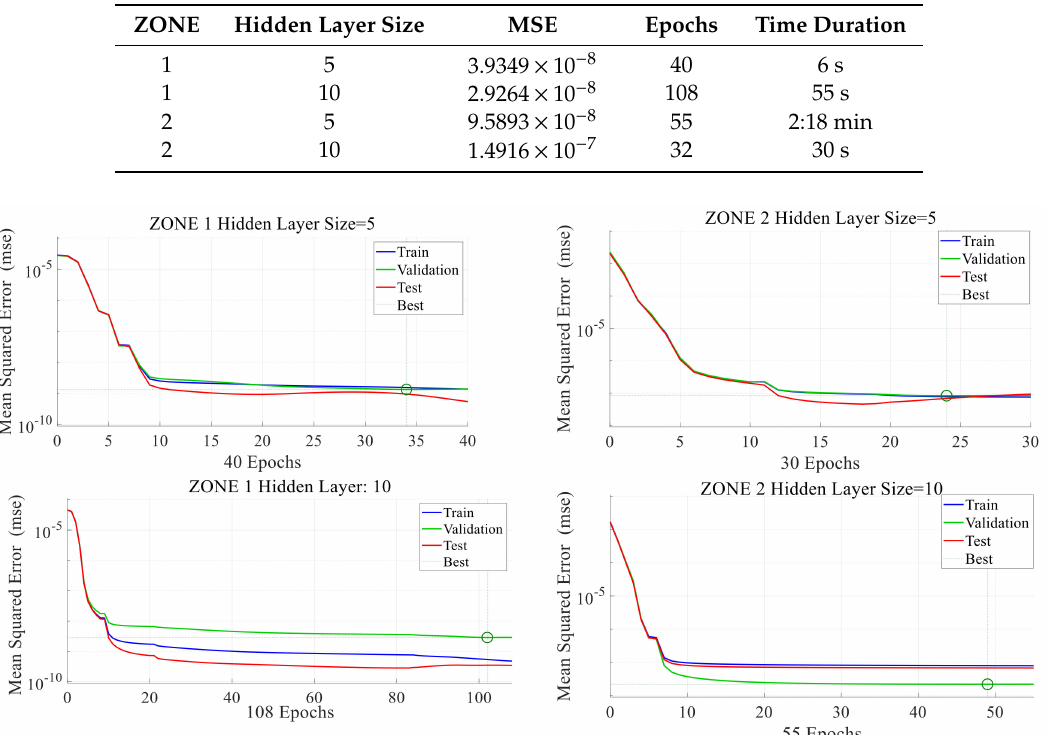
Figure 7. RNARXNN training results for Zone 1 and